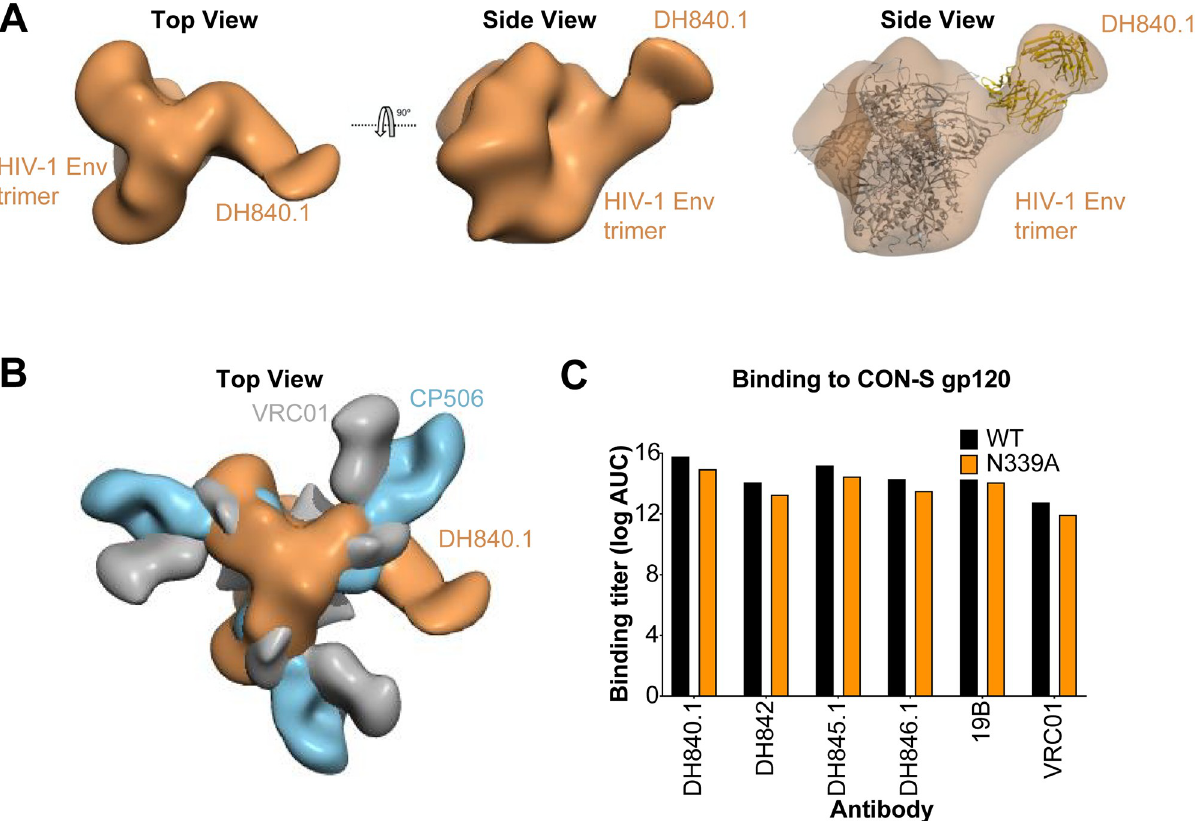
Fig 5. DH840.1 binds to HIV-1 Env in a mode distinct from C3/V4 neutralizing antibodies. (A) 3D reconstruction of negative stain electron microscopy of DH840.1 Fab in complex with HIV-1 stabilized soluble CON-S envelope trimer shown from the top or side of the trimer (Left and Middle). Fitting of the HIV-1 Env trimer and DH840.1 Fab into the negative-stain EM map (Right). (B) Overlay of the negative-stain EM maps of stabilized soluble HIV-1 CON-S envelope trimer in complex with DH840.1 (colored orange), HIV-1 BG505.SOSIP Env trimer with BG505 autologous neutralizing antibody CP506 (blue; EMDB-9003), and HIV-1 Env with CD4 binding site bnAb VRC01 (gray; EMDB-6193). (C) Antibody binding titers as log AUC in ELISA to CON-S gp120 with (black) and without (orange) the N339 glycosylation site.